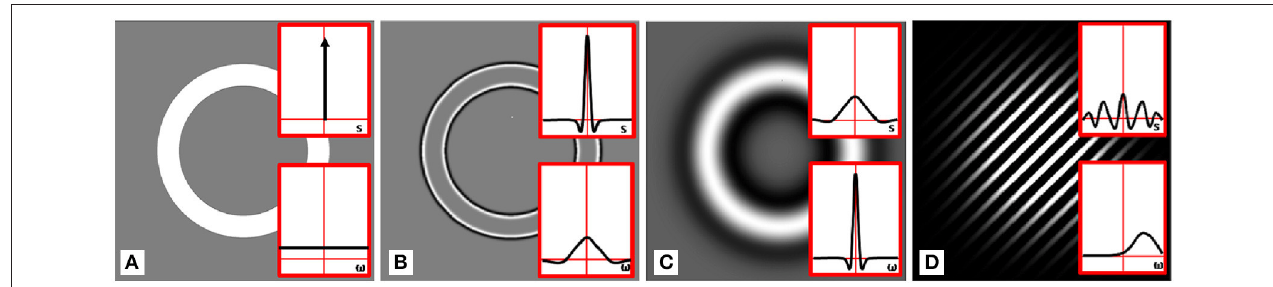
FIGURE 10 | Real-time filtering on an annulus. Insets show 1D cross-sections of the spatial and frequency domain plots of filter kernels, having zero integral. (A) Unfiltered frame, (B) after small-sized difference-of-Gaussians filtering, (C) after larger difference-of-Gaussians filtering. Note that after a double-Gaussian filtering with zero integral, a homogeneous area is mapped to zero (black), while around the edges, intensity values beyond the [0 ... 1] dynamic range can occur. In order to fit into the dynamic range, a linear mapping from the resulting intensity interval into the dynamic range has been applied. Therefore, the regions with zero intensity get a value corresponding to a gray shade. (D) Small spot filtered with phase-shifted Gaussian (Gabor)